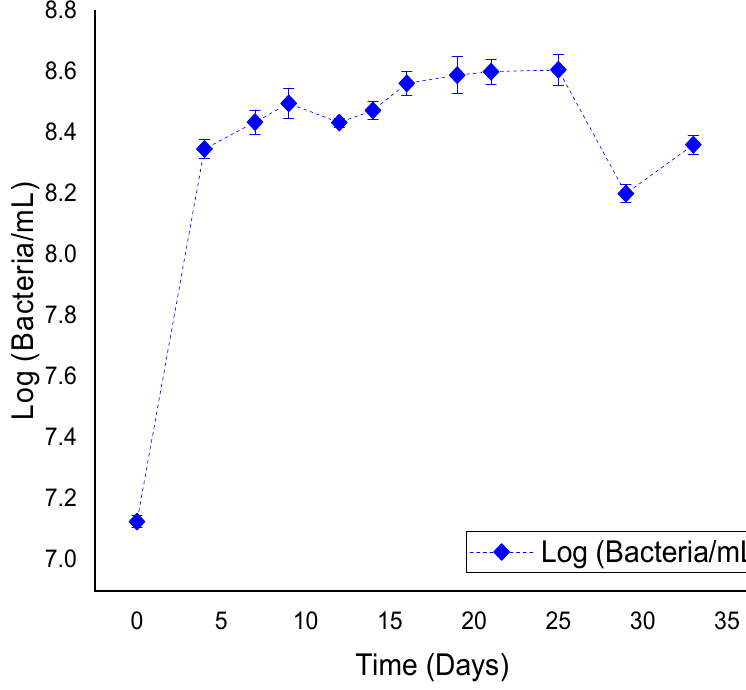
Figure 1. Growth curve of the microbial consortium isolated from submerged tire segments from a swampy area on the Socabaya River, Arequipa.